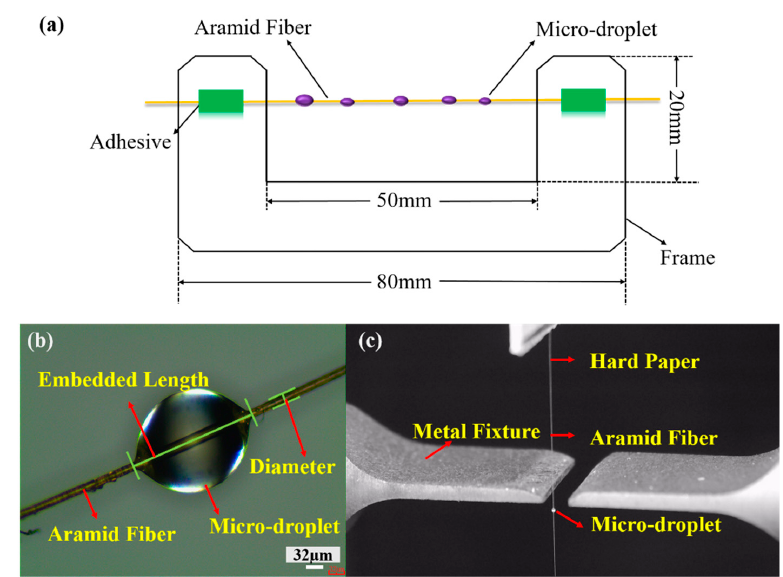
Figure 2. Simulation diagram of depositing microdroplet on the fiber ( a ). Images of AF–microdroplet ( b ) and the debonding device ( c ).